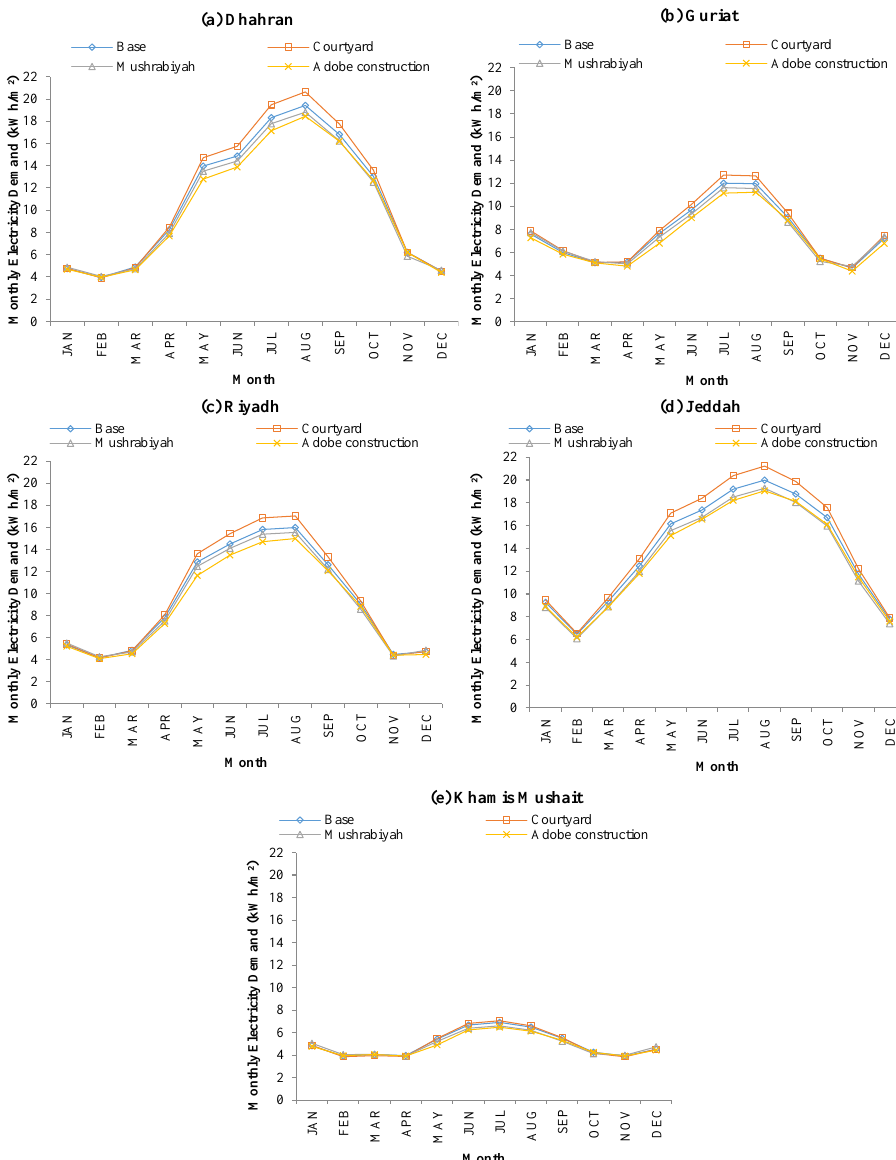
Figure 15. The annual electricity performance of the base, courtyard, mushrabiyah and adobe construction houses in ( a ) Dhahran; ( b ) Guriat; ( c ) Riyadh; ( d ) Jeddah; and ( e ) Khamis Mushait.